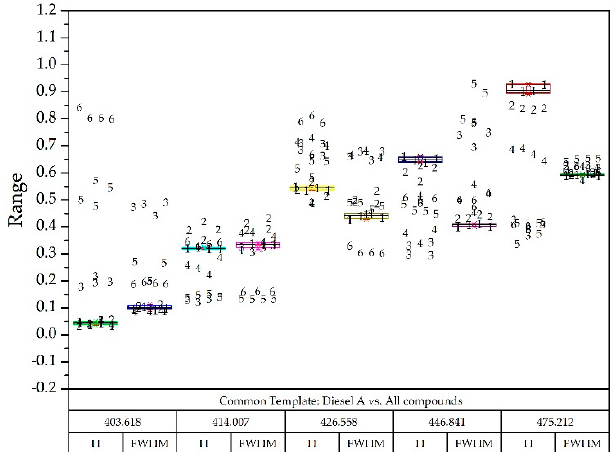
Figure 12. Diesel A box-plot diagram superimposed on all other compounds identified with numbers: Diesel A (1), Diesel A with additives (2), Diesel B (3), Diesel C (4), Gasoline 95 (5) and Gasoline 98 (6).